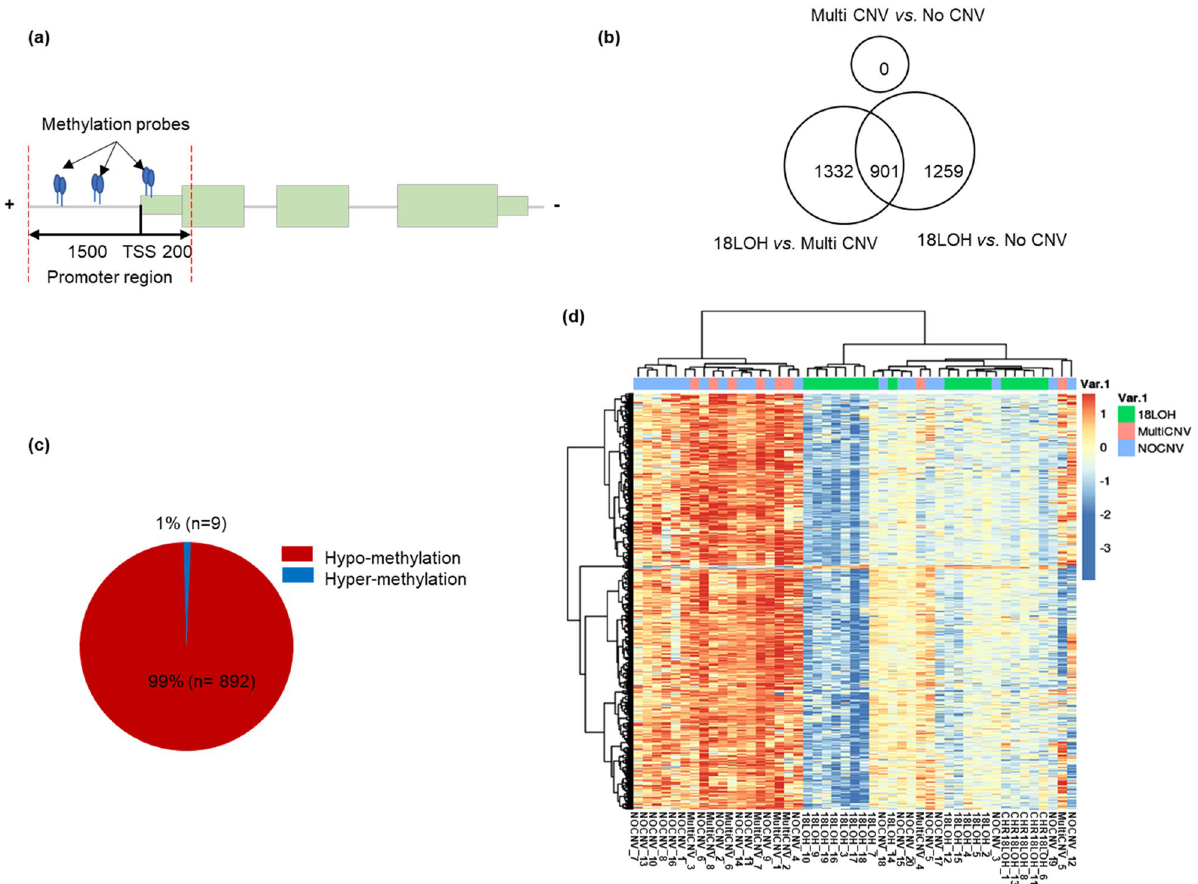
Figure 2. Differential methylation status between molecular subtypes. ( a ) A schema methylation probes within promoter region. Methylation probes between − 1500 and 200 bp from the transcript start site are considered. ( b ) The number of significantly differential methylation genes of each comparison. The overlapped differential methylation of 18LOH versus Multi CNV and 18LOH versus No CNV is considered as 901 genes specific to 18LOH. ( c ) Proportion of hypomethylated (n = 892, 99%) and hypermethylated (n = 9, 1%) genes in 18LOH tumors. ( d ) Heatmap of 901 differentially methylated genes for each tumor. Blue indicates hypomethylation. Red indicates hypermethylation. Tumor molecular subtypes are indicated in green (18LOH), pink (MultiCNV) or blue